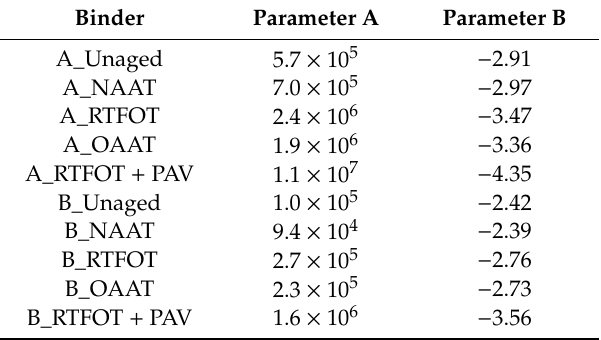
Table 5. Linear amplitude sweep (LAS) parameters.